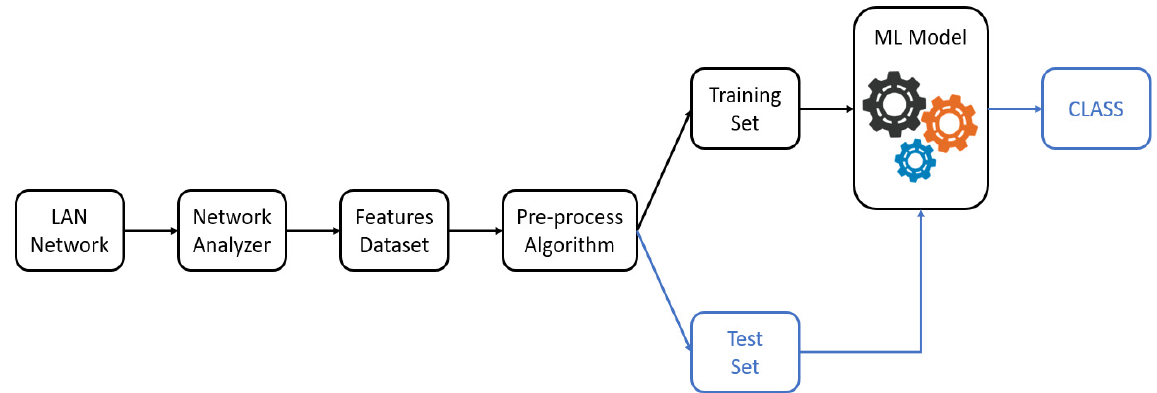
Figure 2. Machine-learning workflow in intrusion detection.